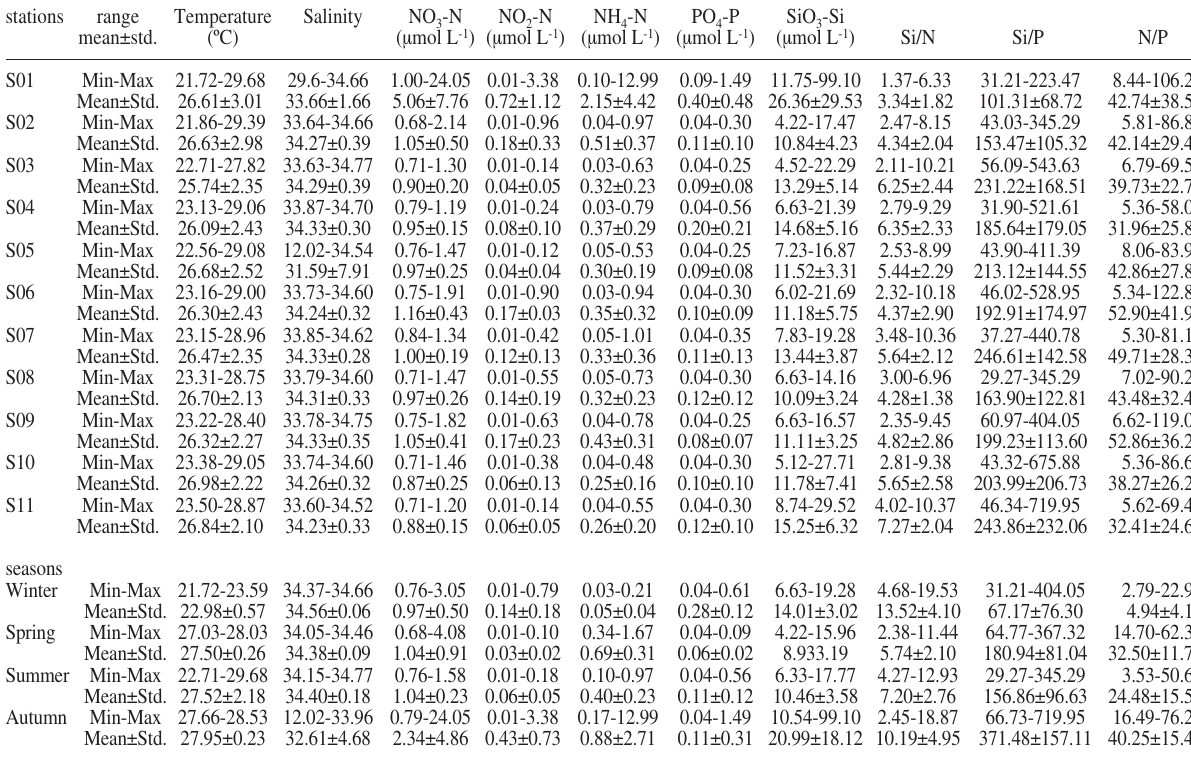
Table 4. – Pearson correlation coefficients among the environmental variables and phytoplankton in Sanya Bay in four seasons 2005(* P <0.05, Seasons algae